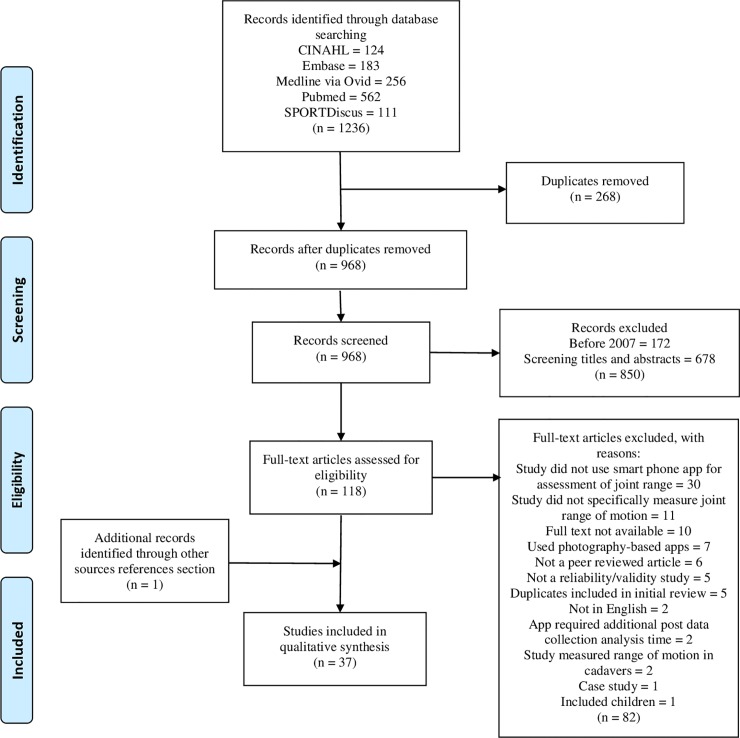
PRISMA flow chart of the screening process.